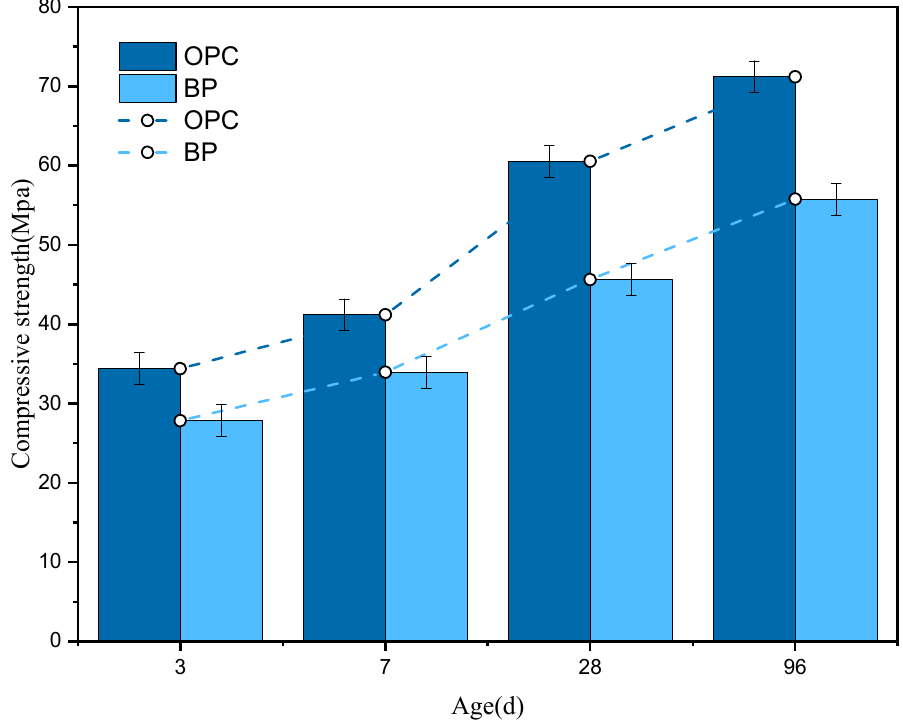
Figure 11. Compressive strength of the OPC pastes and BP pastes at different curing ages.